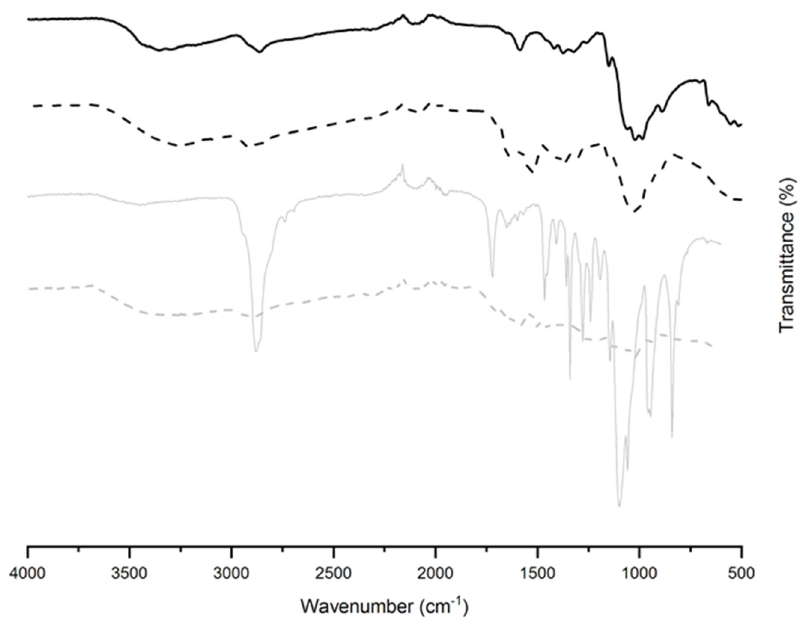
Figure 2. FTIR spectra. Unmodified CS (black solid line); modified CS (black dashed line); non-conductive hydrogel (grey solid line); conductive hydrogel (grey dashed line).